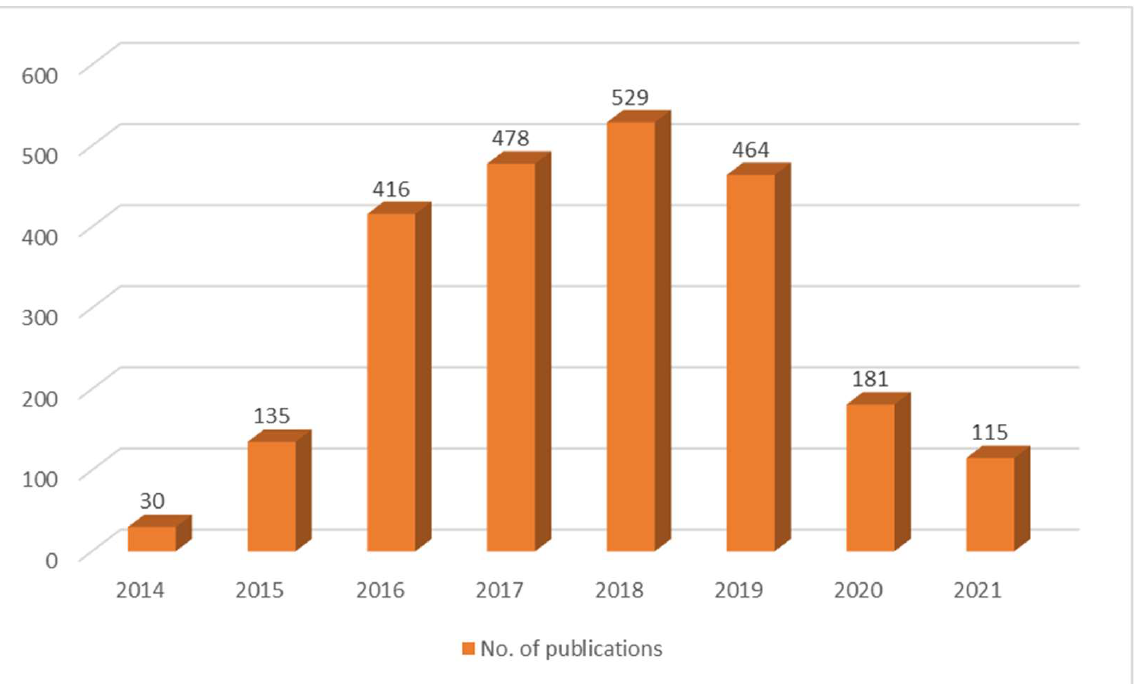
Figure 4. Project deliverables and scientific production. 4.4. RQ4: Which Are the Most Cited Authors and Documents? Table 2 presents the top 10 most cited authors. In addition to the total number of citations per author, the number of documents written by each author is also presented.